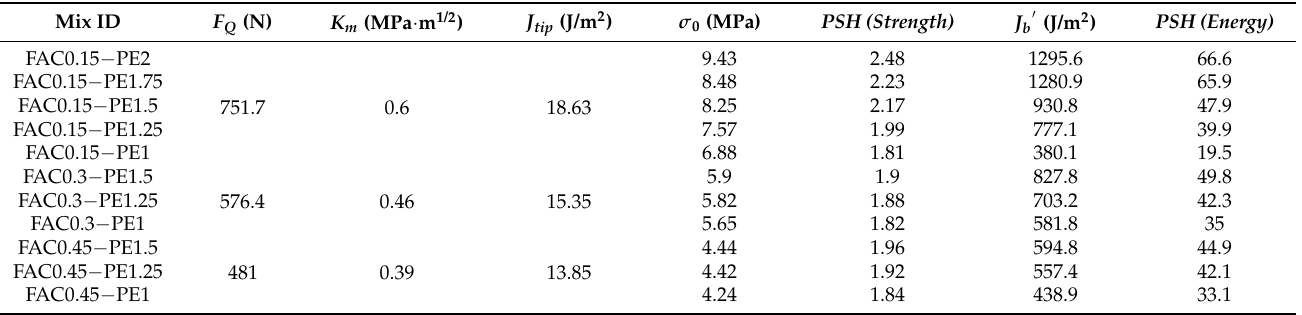
Figure 13. Fiber bridging stress–crack opening curves of GLECC mixtures. ( a ) FAC0.15 − PE1.75; ( b ) FAC0.15 − PE1.5; ( c ) FAC0.15 − PE1.25; ( d ) FAC0.15 − PE1; ( e ) FAC0.3 − PE1.5; ( f ) FAC0.3 − PE1; ( g ) FAC0.45 − PE1.25; ( h ) FAC0.45 − PE1. Table 4. Strain hardening index analysis of